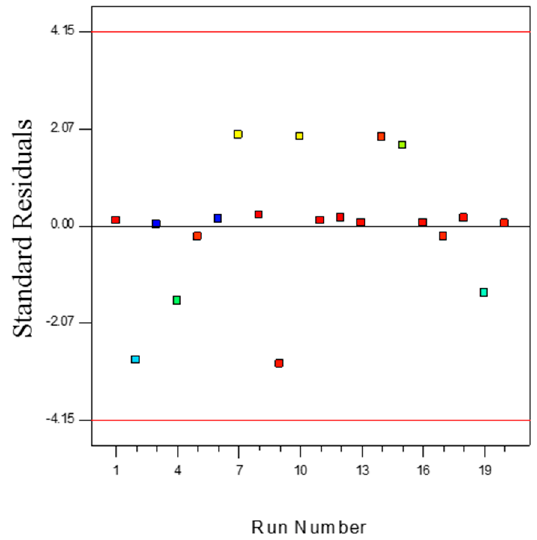
Figure 11. Outlier t plot for propylene polymerisation (%) per pass.